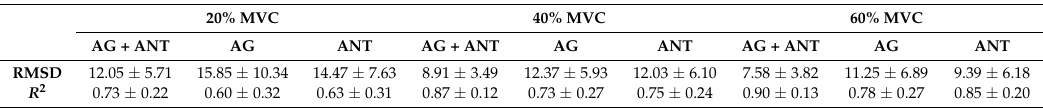
Table 4. The force estimation RMSD and R 2 (average ± standard deviation) for all subjects. (AG: agonist muscle, ANT: antagonist